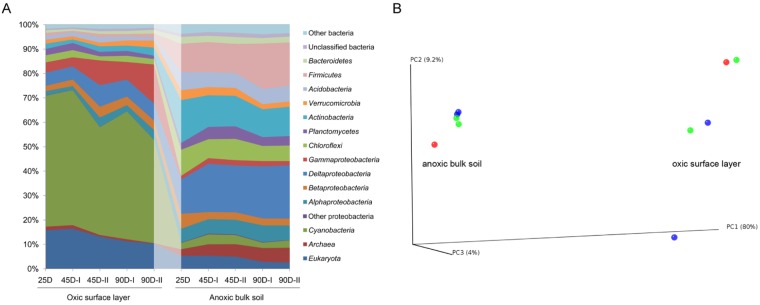
Phylum-level changes in microbiome composition in the oxic and anoxic zones over incubation period (A) and principal coordinate analysis based on the weighted UniFrac distance matrix (B).